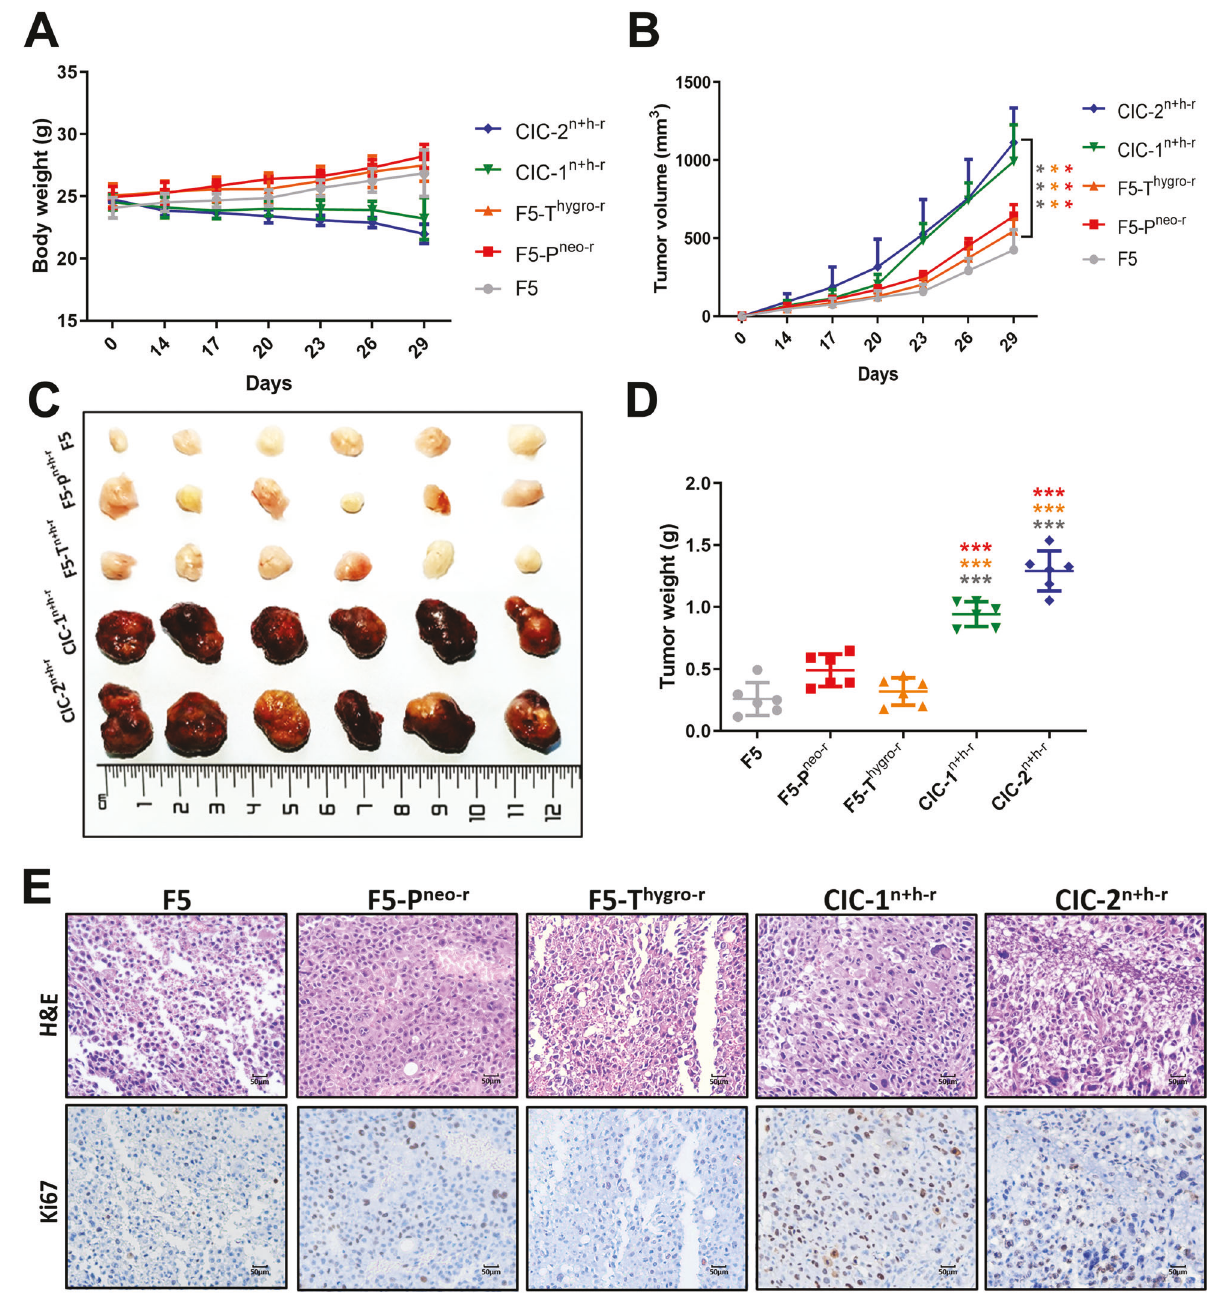
Fig. 5 The effect of dual-antibiotic-resistant clones CIC-1 n + h-r and CIC-2 n + h-r cells on xenograft tumor growth. A Mice body weight with time course. B Tumor growth of F5, F5-P neo-r , F5-T hygro-r , CIC-1 n + h-r and CIC-2 n + h-r with time course. C Visual comparison of F5, F5-P neo-r , F5- T hygro-r , CIC-1 n + h-r and CIC-2 n + h-r cells dissected tumor tissues. D The tumor weight of F5, F5-P neo-r , F5-T hygro-r , CIC-1 n + h-r and CIC-2 n + h-r at the indicated time point. E HE staining and Ki67 in subcutaneous xenografts in nude mice.